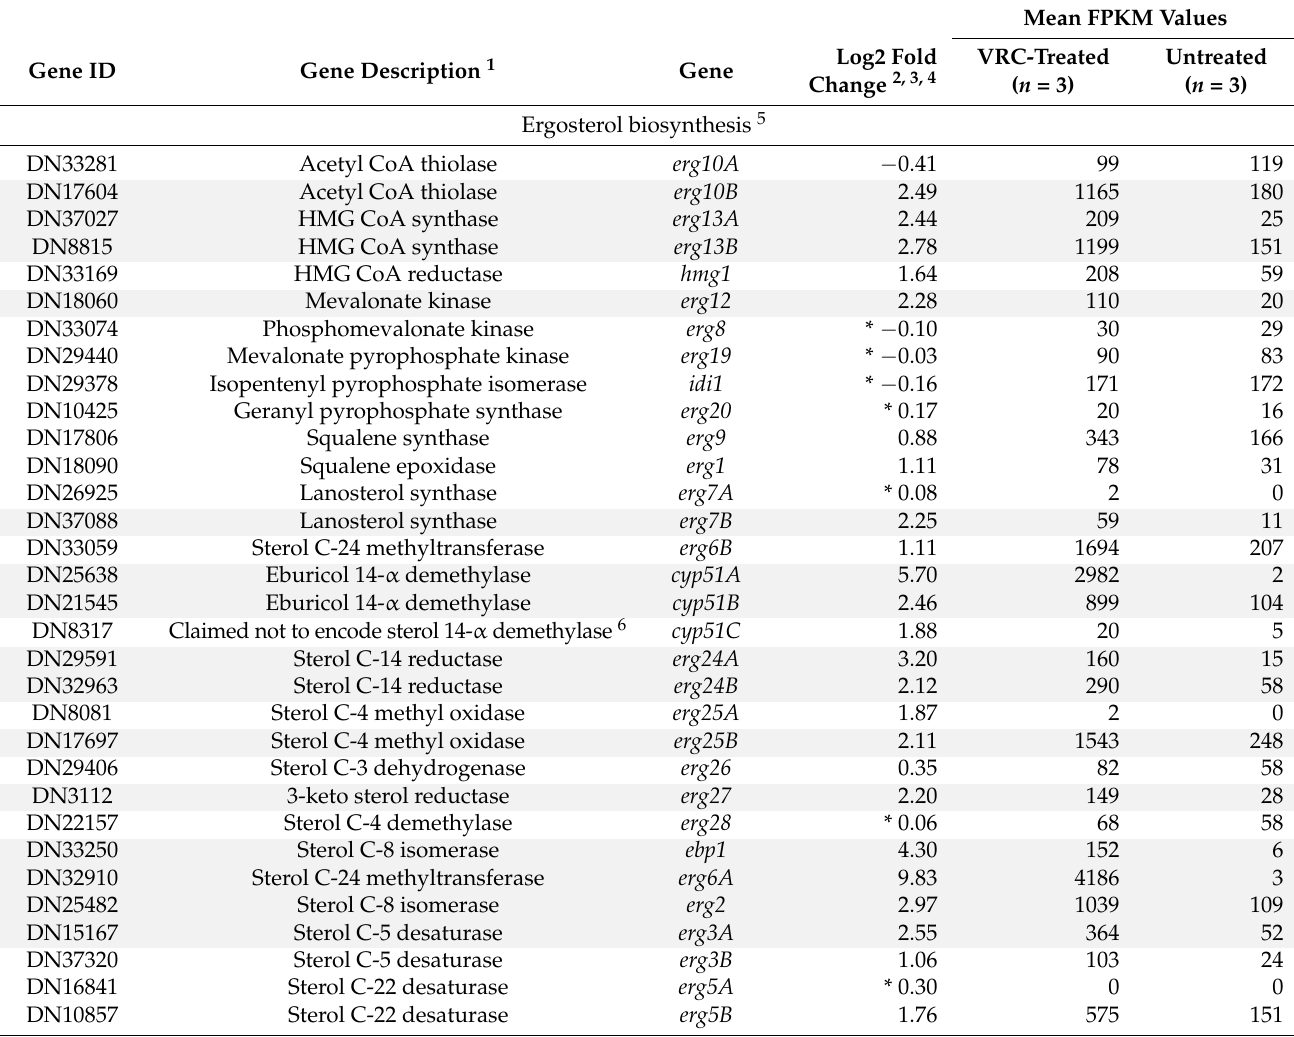
Table 2. Expression levels of DEGs involved in ergosterol biosynthesis, drug efflux and gene regula- tion which could contribute to F. keratoplasticum azole resistance. Log2 fold-change and mean FPKM values of all other significant DEGs are available in Supplementary File S2. Mean FPKM